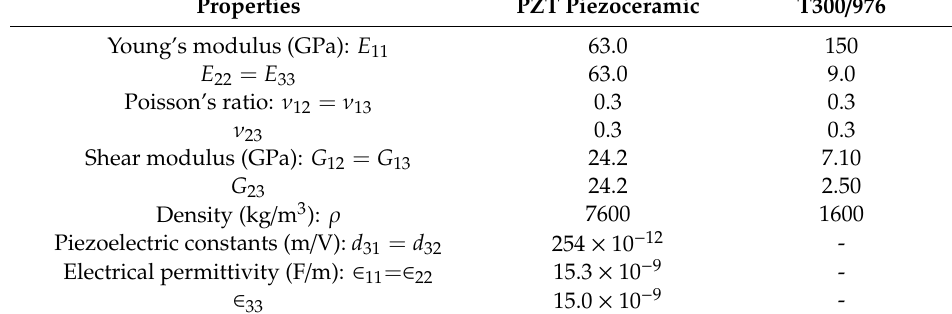
Table 1. Material properties [21].